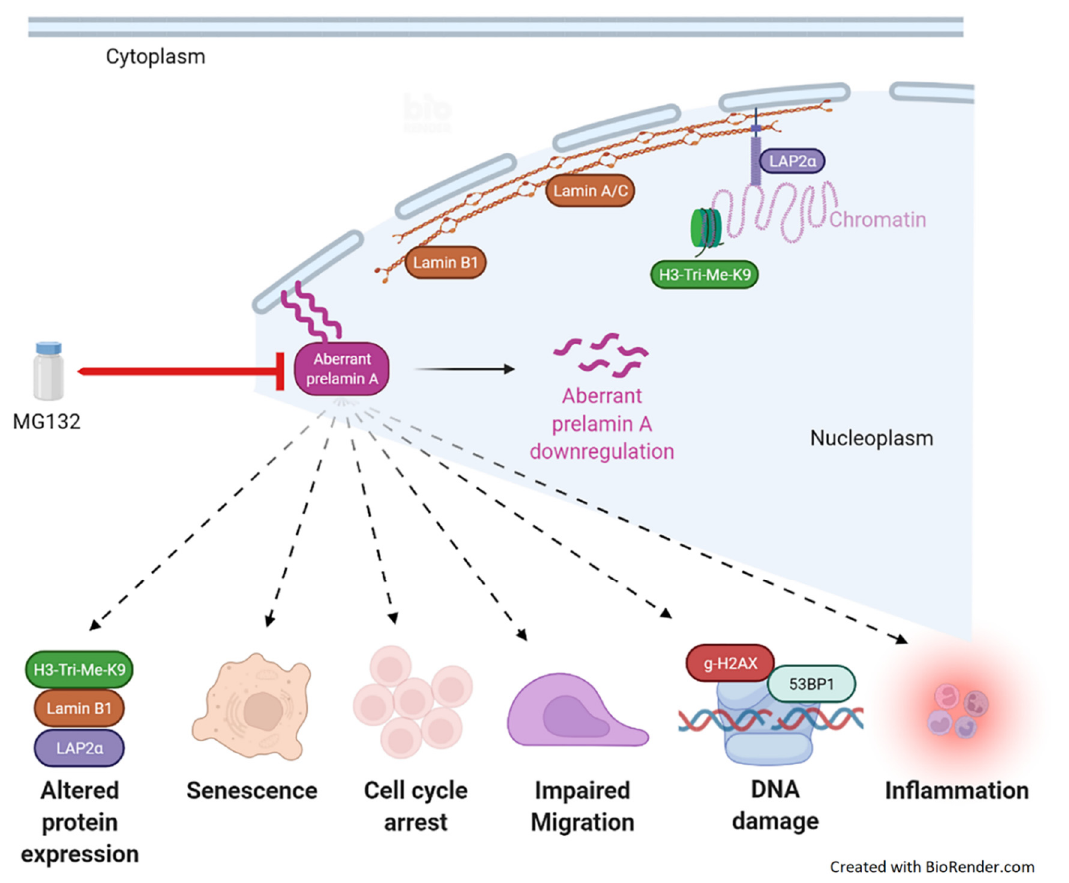
Figure 7. Schema summarizing the results of the current study. MG132 reduces the transcript levels of the aberrant prelamin A isoforms and the corresponding proteins already expressed. MG132 treatment improves several pathological parameters, including altered protein expression, cellular senescence, cell cycle arrest, impaired migration, DNA damage, as well as inflammatory cytokine expression.